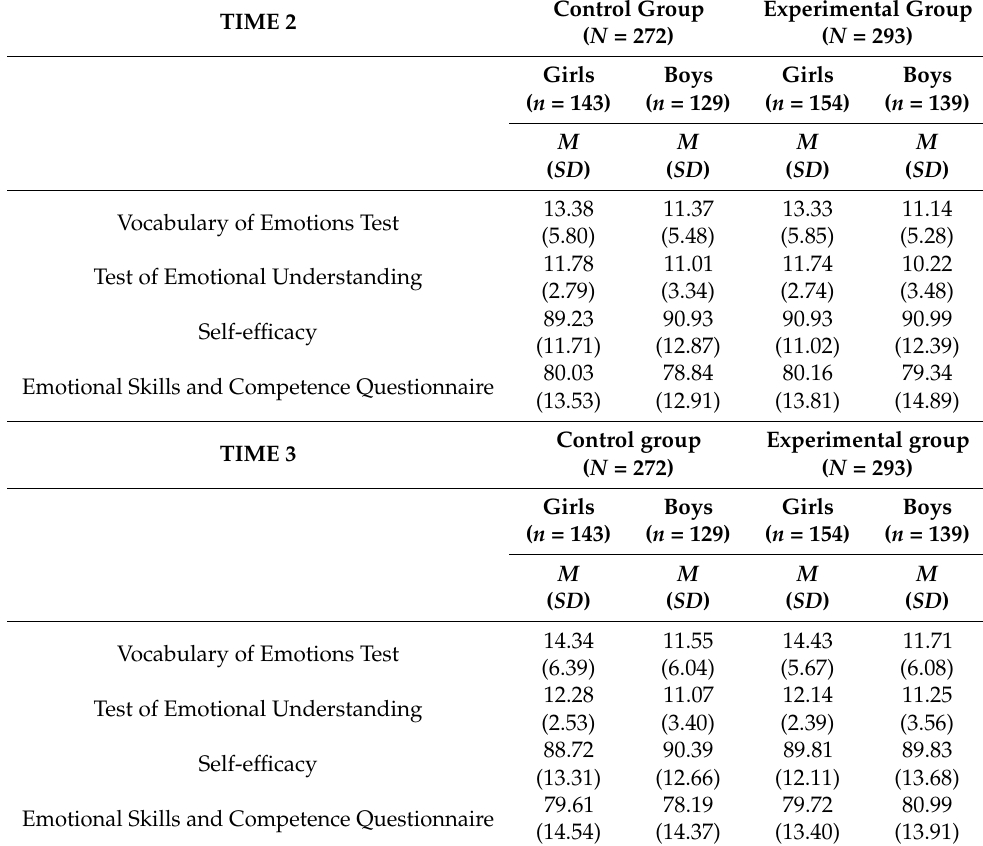
Table 4. Post intervention group differences on all